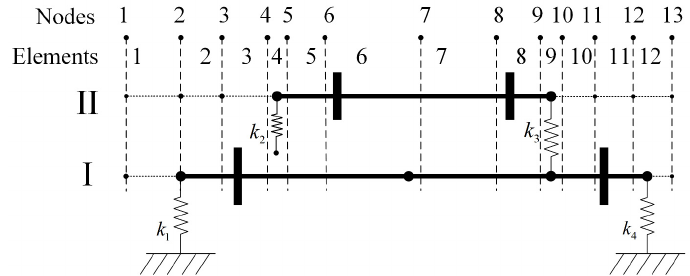
Figure 2. Element division of the dual ‐ rotor system.